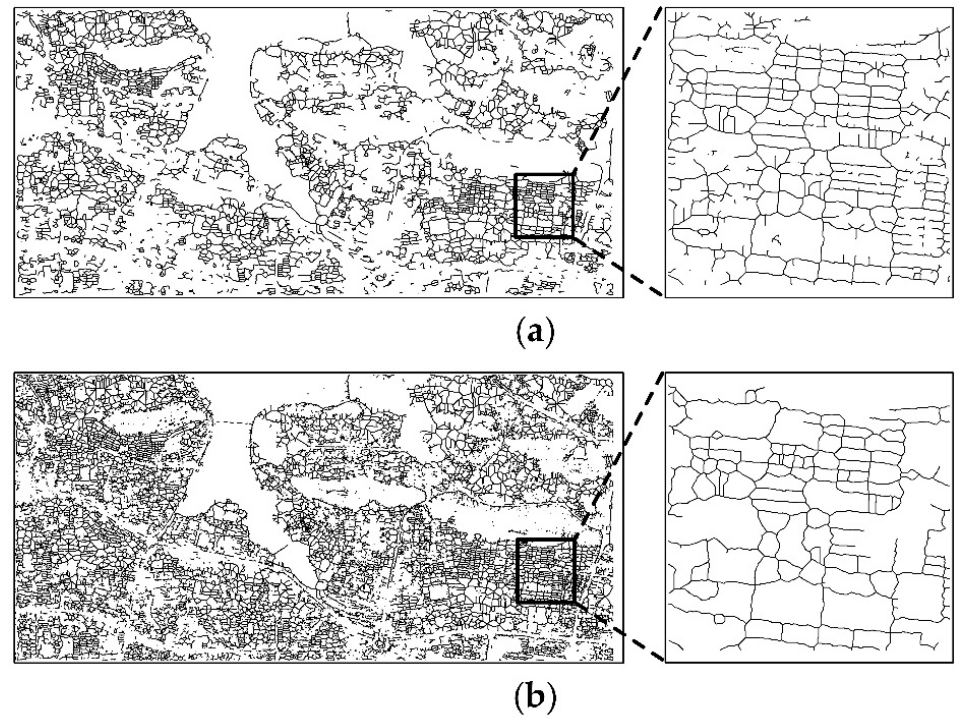
Figure 14. Experiments of skeleton extraction: ( a ) result of thinning; ( b ) result of spur removal.